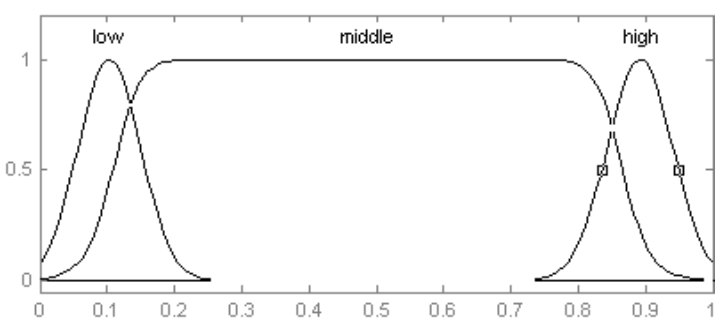
Figure 6. Membership functions of